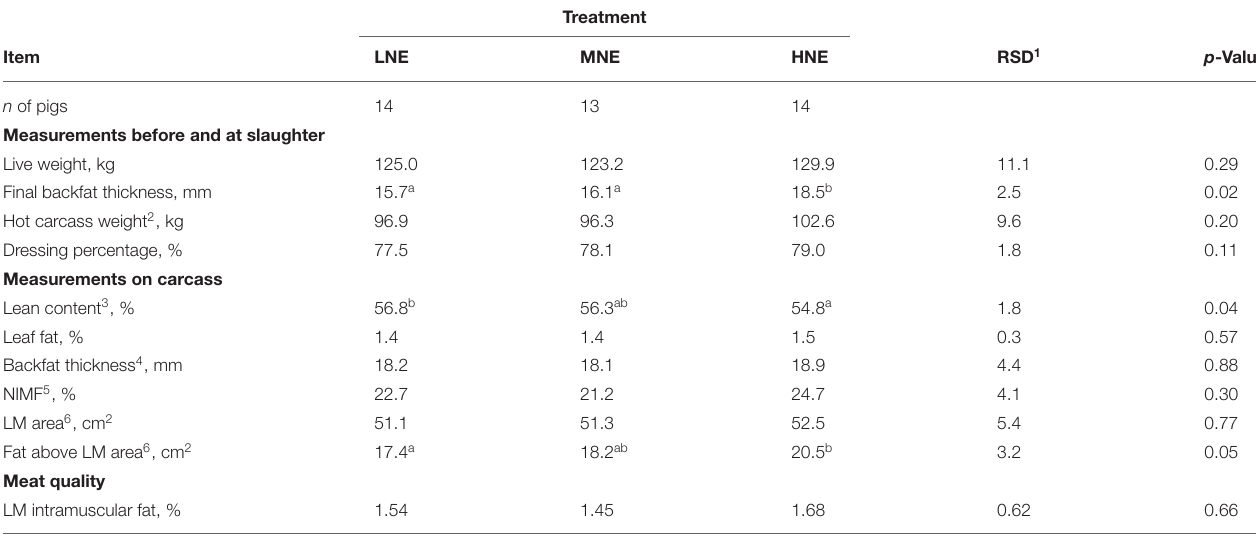
TABLE 7 | Effect of changes in dietary net energy concentration on carcass and meat quality traits.